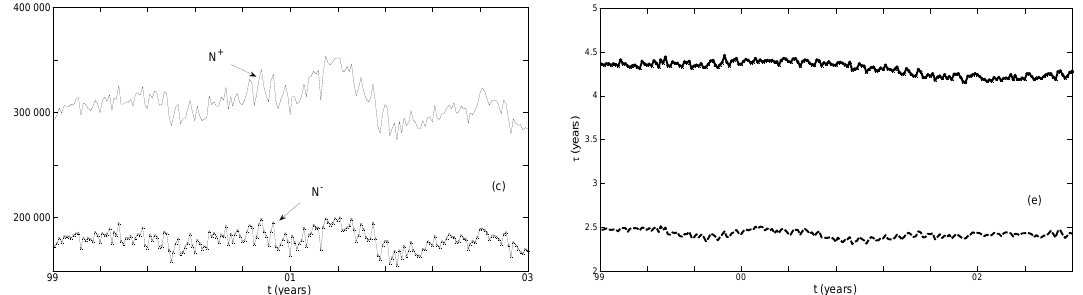
Figure 6. Temporal behavior of the number and timescale of near-resonance quartets corresponding to quasi-zonal jets and biannual oscilla- tions in 1999–2003. (a) Number of near-resonance quartets that participated in inter-scale interactions to generate the energy for quasi-zonal jets (QZJs) ( N + ) and biannual oscillations (BAOs) ( N − ). (b) Mean timescales for QZJs (–) and BAOs (–).